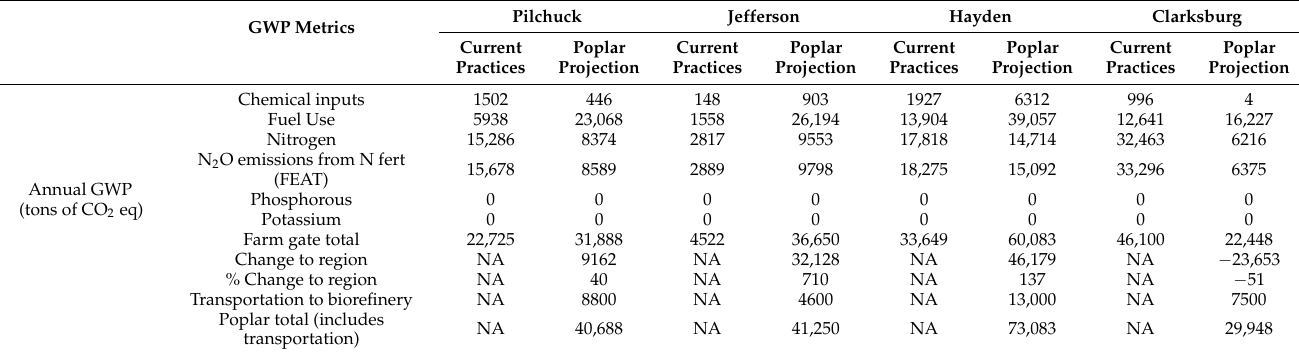
Table 10. Regional Global Warming Potentials.